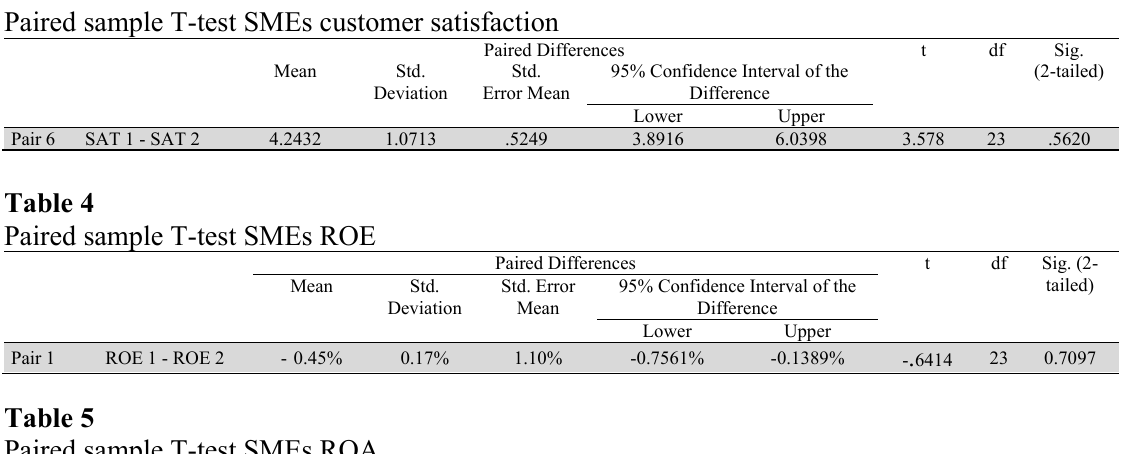
Paired Differences